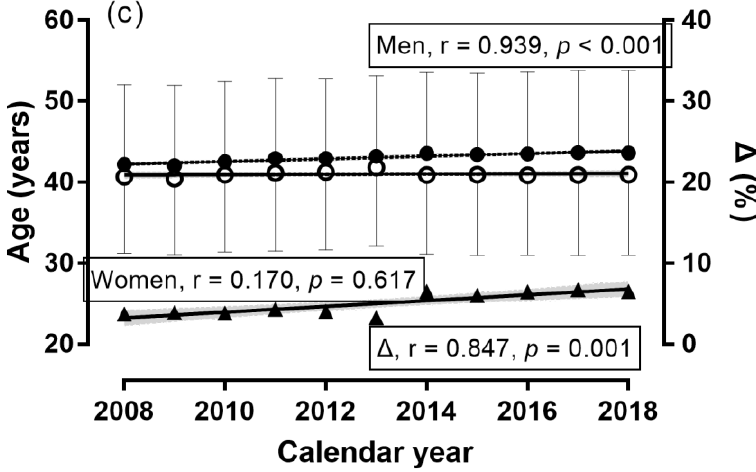
Figure 3. Age of finishers by calendar year. Note: Δ = sex difference; error bars denote standard deviation; shadowed areas denote 95% confidence intervals; = women, ⚫ = men.